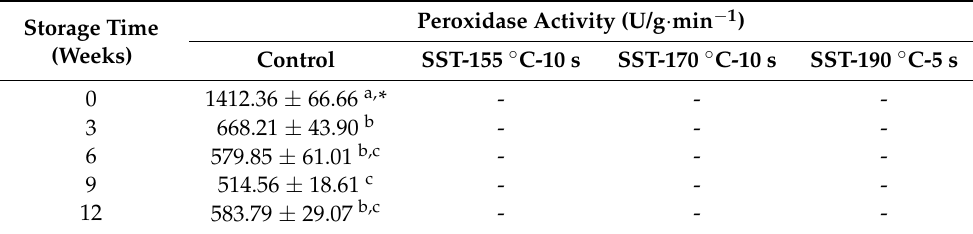
Table 3. Effect of superheated steam treatment on peroxidase activity of dried whole wheat noodles during